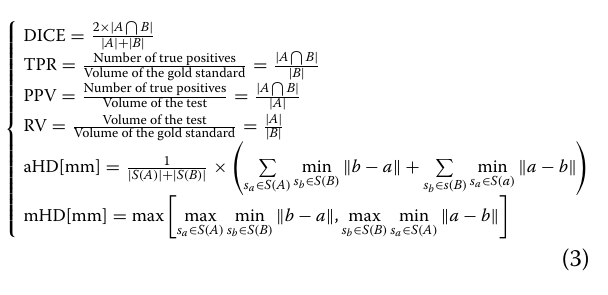
Role of perfusion territory segmentation in dosimetry In the SIRT workflow, the volumes of the right